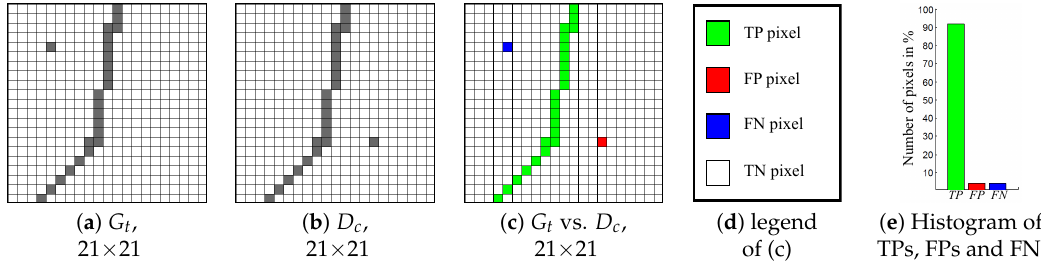
Figure 3. Example of ground truth ( G t ) versus (vs.) a desired contour ( D c